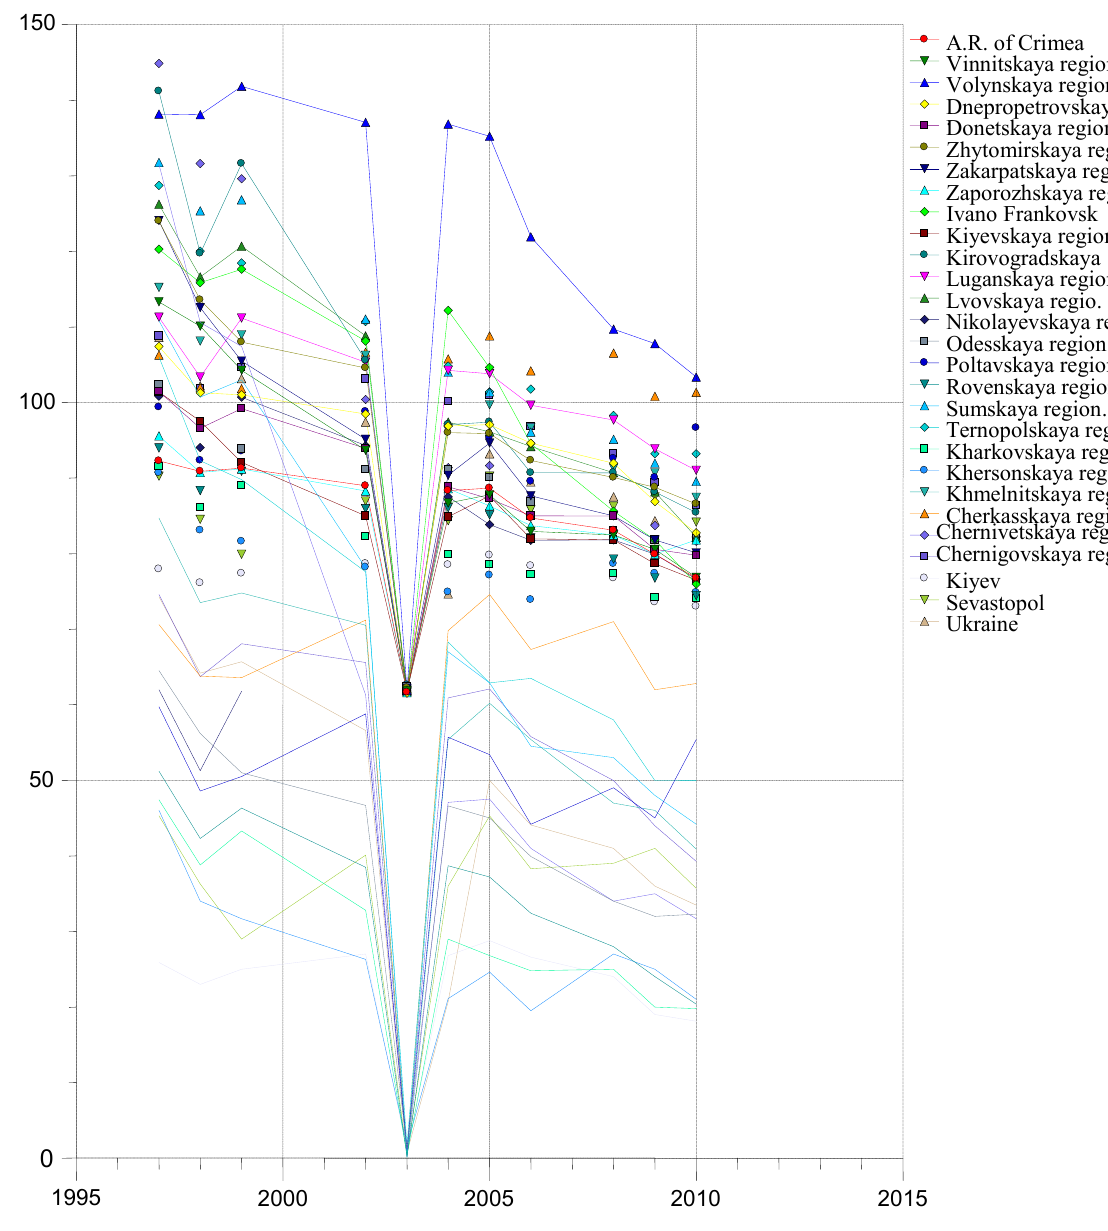
Fig. 3. Mean quantity of deaths , respiratory organs’ diseases per 100 thousand of